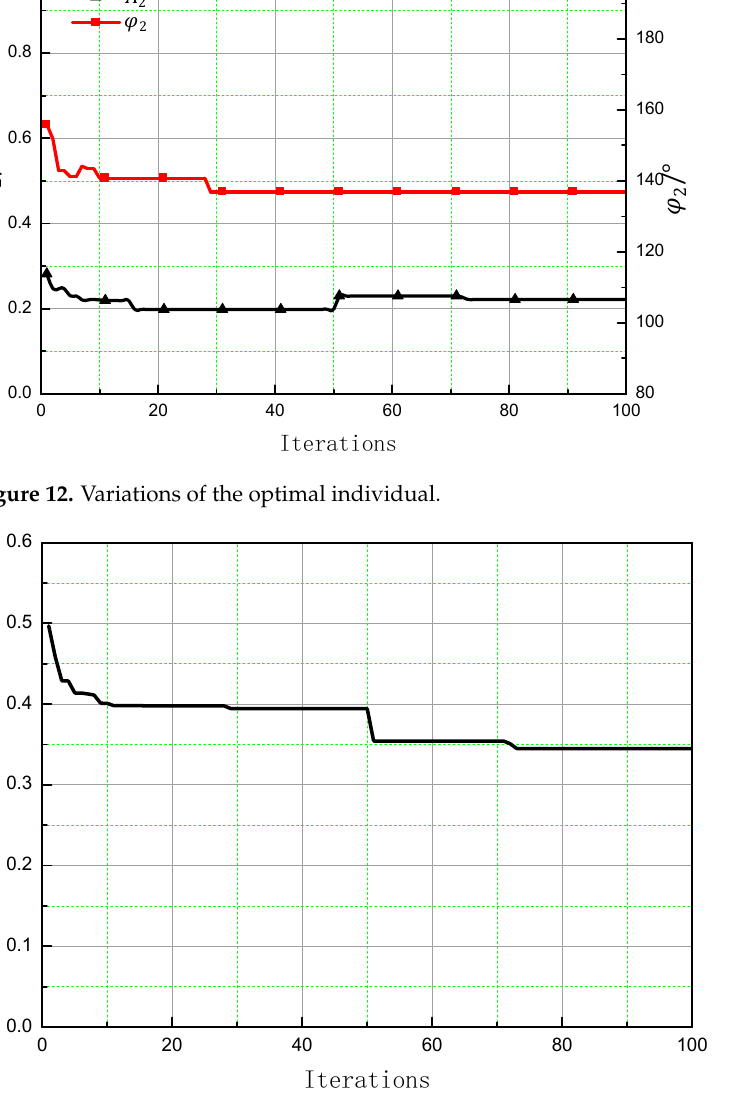
Figure 13. The trend chart of Fv under each generation of optimal individuals.